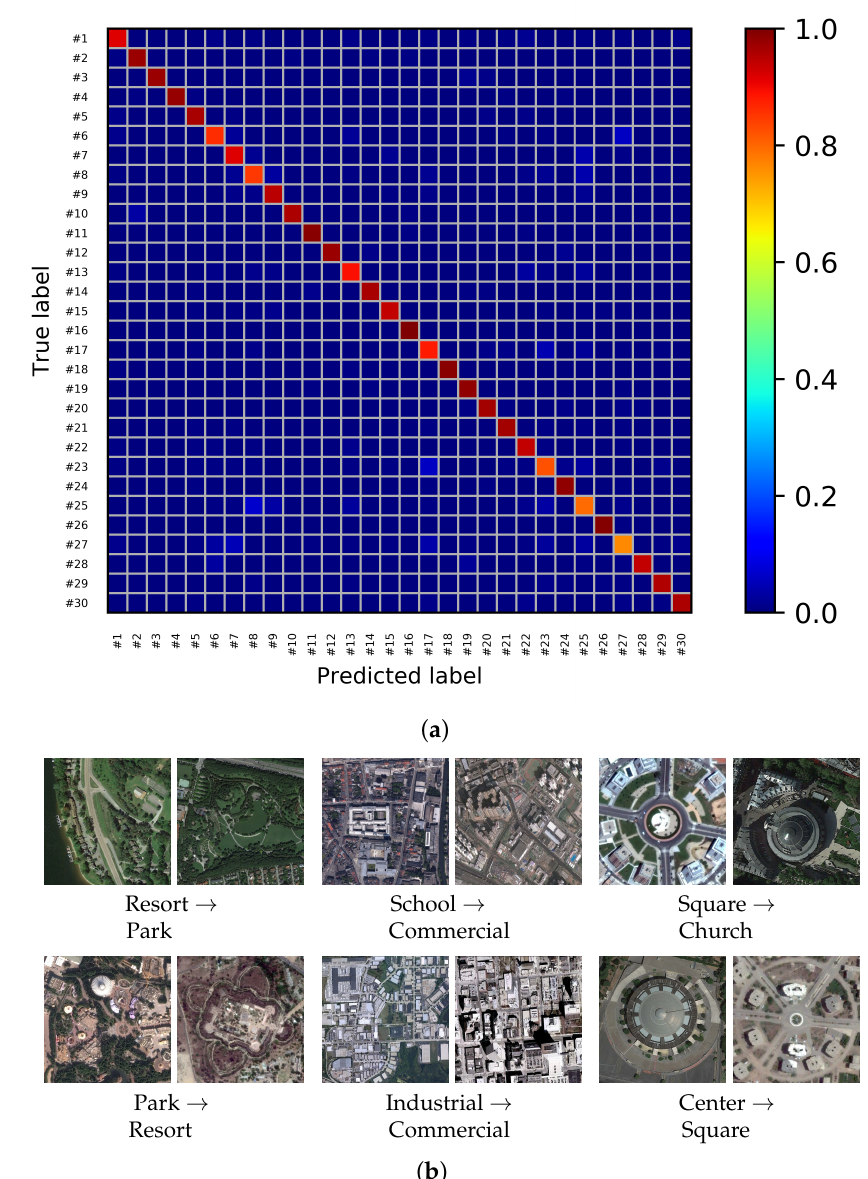
Figure 9. Confusion matrix and some misclassification examples for the AID dataset using the proposed MDFR architecture. ( a ) Confusion matrix of the AID dataset with OA = 93.64%. ( b ) Some misclassified samples of the AID